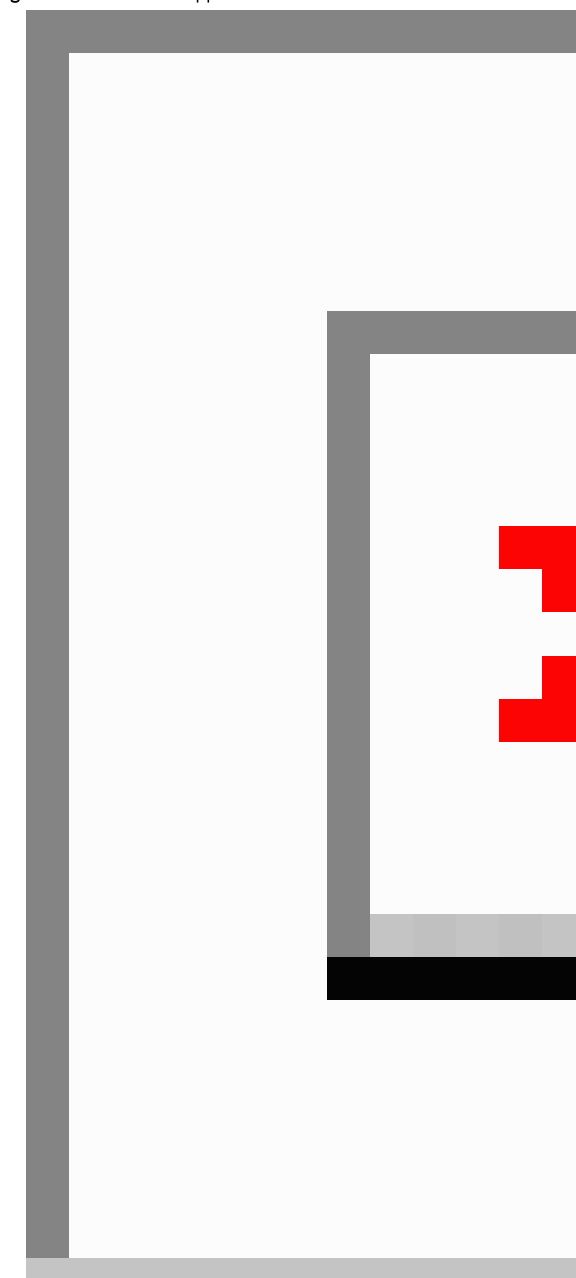
Figure 2. Emotional support